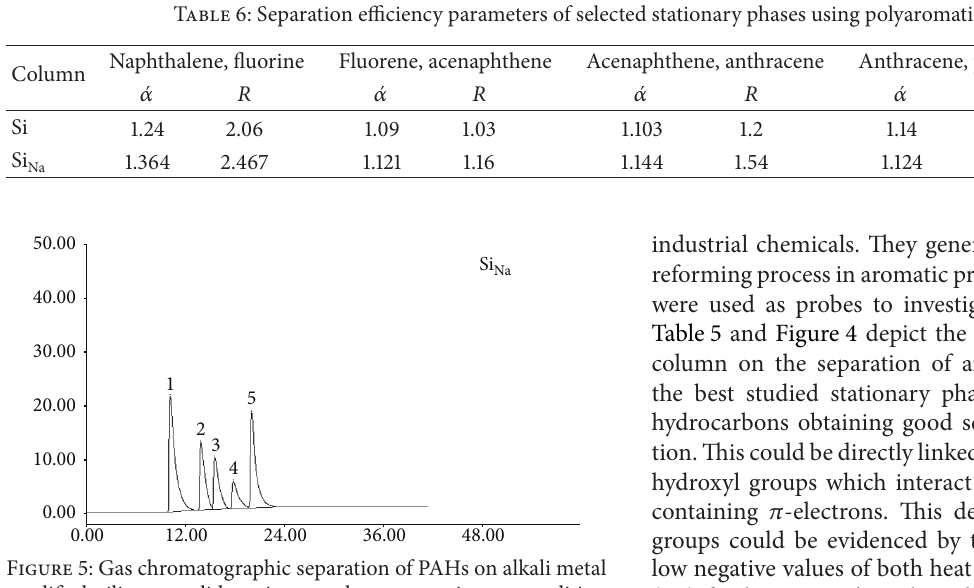
and to 300 ∘ C CBo 10 %